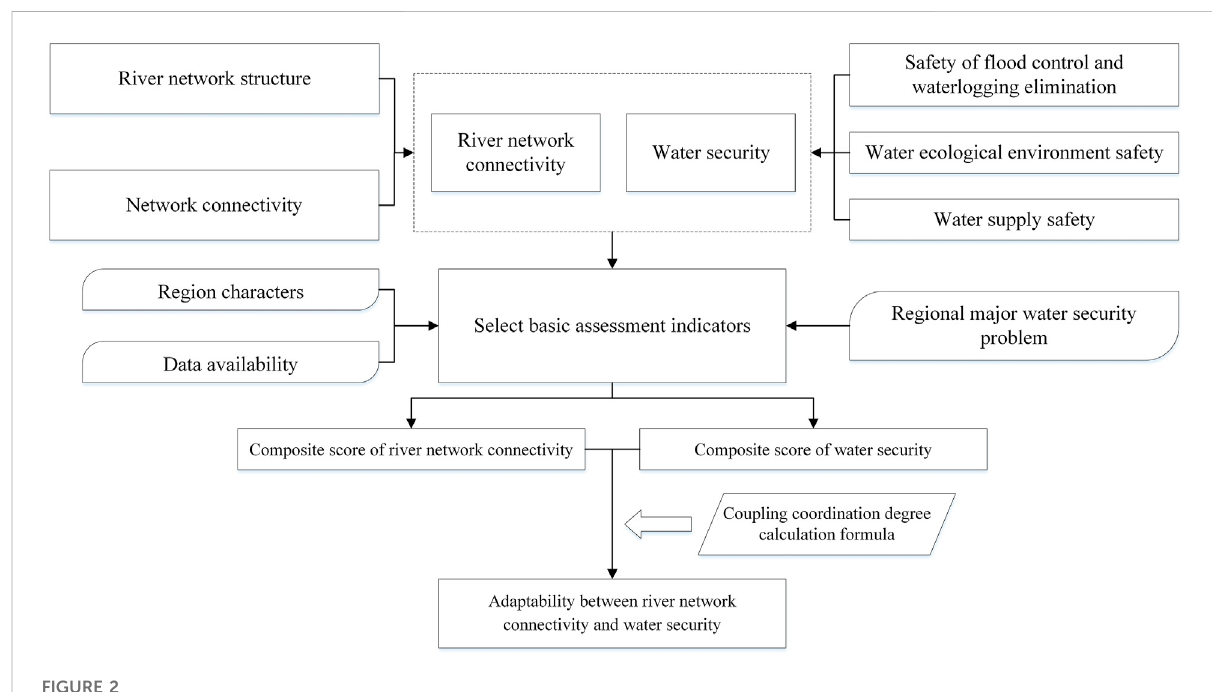
FIGURE 2 Assessment framework of adaptability between river network connectivity and water security.